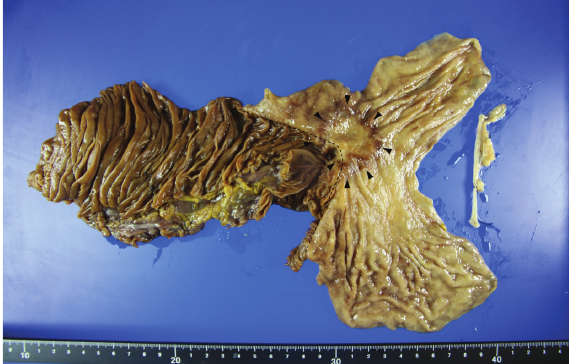
Figure 5: Resected specimen. The resected stomach contained an infiltrative-ulcerative type tumor, 25 × 25mm in size (black arrowhead). The black dote line showed the gastrojejunostomy at initial